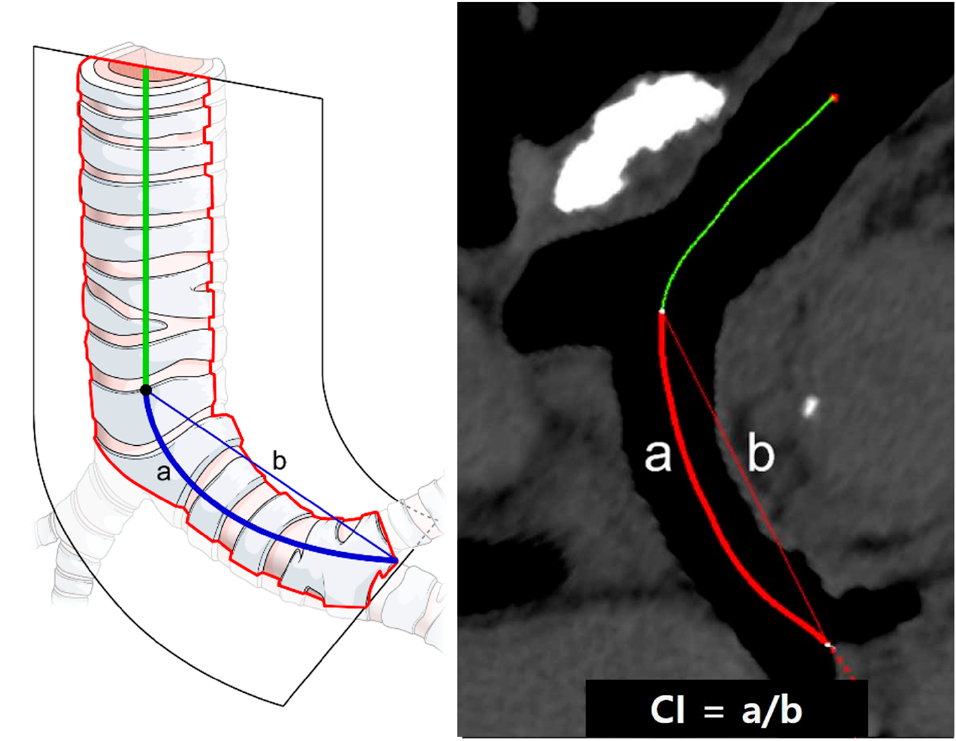
Figure 4. Measurement of left main bronchus tortuosity. Curvature index was used to measure the tortuosity of the left main bronchus. Center line passing through the distal trachea and left main bronchus was automatically created and carefully modified as needed. Distance of curved center line from carina to second carina (a) and over distance of straight line from carina to second carina (b) was used as curvature index (a/b), representing the tortuosity of left main bronchus. Higher indices indicated greater tortuosity